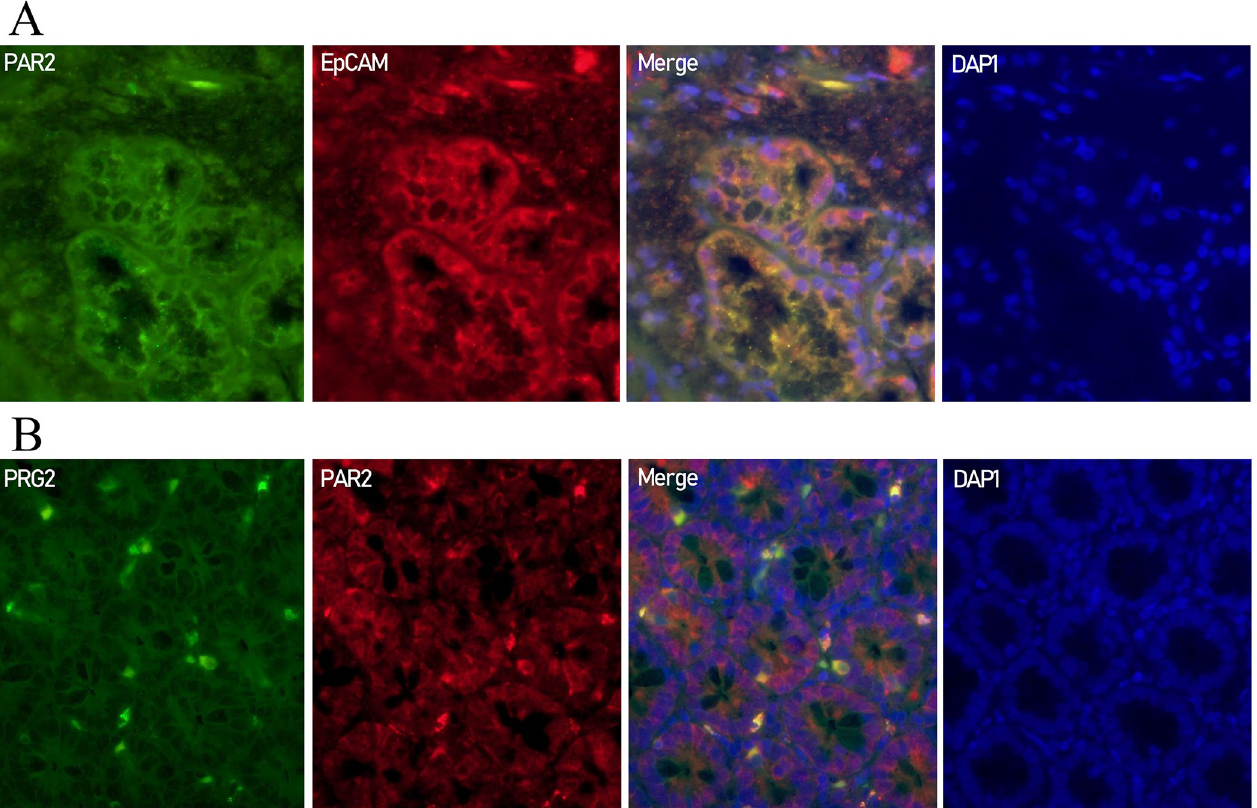
Fig 9. Colocalization of PAR2 and EpCAM or PAR2 and degranulated eosinophils in the duodenum of patients with FD-P. Fig 9A. PAR2-positive cells (green cells) in the duodenum of patients with FD-P. EpCAM-positive cells (red cells) in the duodenum of patients with FD-P. PAR2 and EpCAM expressions were mainly coexpressed in the same section. Double-positive cells (yellow cells) reveal PAR2- and EpCAM-positive cells in the same section. 4’, 6-diamidino- 2-phenylindole staining (blue cells). Fig 9 B. PRG2-positive cells (green cells) in the duodenum of patients with FD-P. PAR2-positive cells (red cells) in the duodenum of patients with FD-P. PRG2 and PAR2 expressions were coexpressed in the same section. Double-positive cells (yellow cells) reveal PRG2- and PAR2-positive cells in the same section. 4’, 6-diamidino-2-phenylindole staining (blue cells).